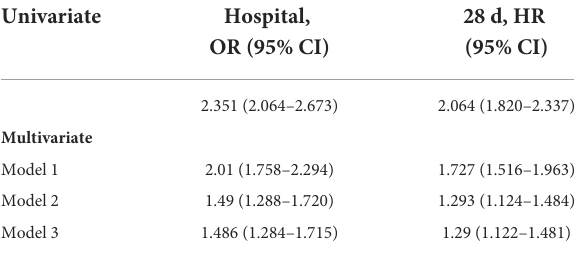
TABLE 2 ORs and HRs associated with in-hospital mortality and 28-day